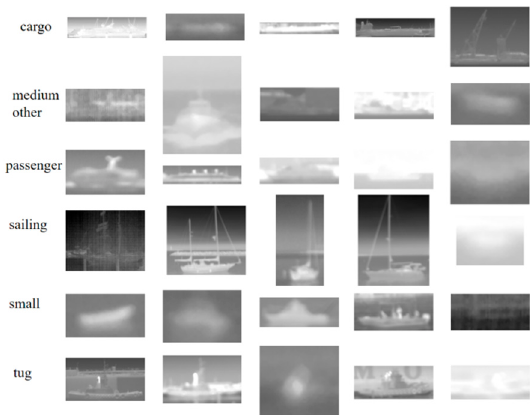
Figure 5. Some infrared image of VAIS dataset.